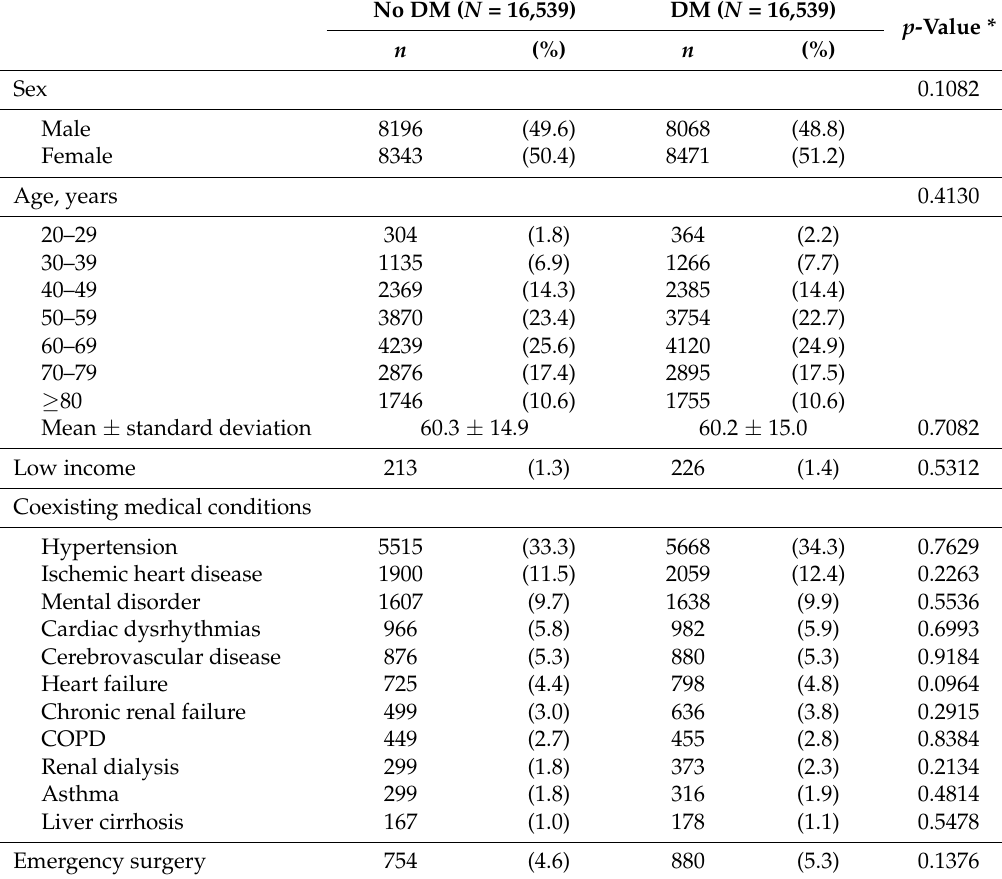
Table 2. Baseline characteristics of surgical patients with and without diabetes after matching with propensity